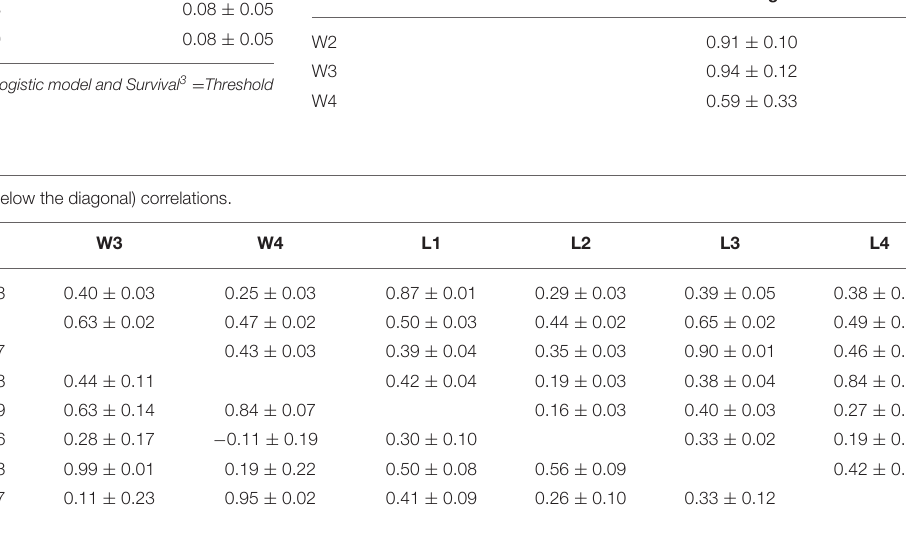
TABLE 5 | Effect of genotype by environment (G Traits